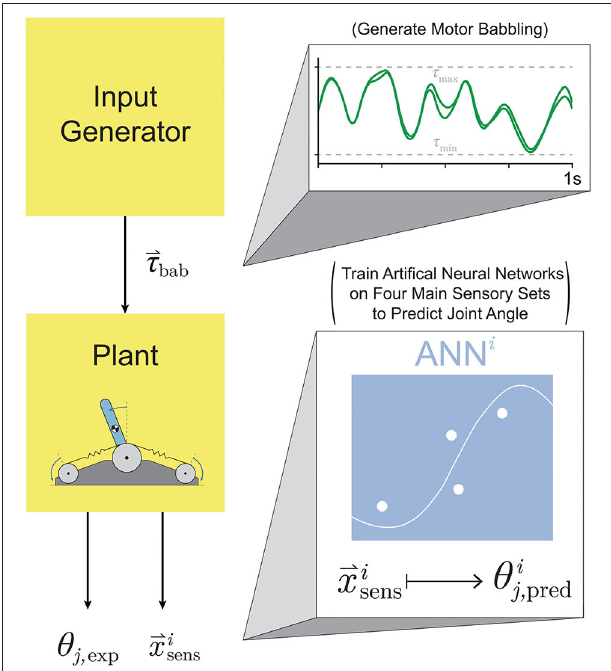
FIGURE 4 | Proposed setup for training ANNs on motor babbling. Random input torques were generated from low frequency, band-limited white noise (1-10 Hz) chosen such that the difference between the two signals forms a normal distribution (0 ± 0.5 Nm). These motor babbling signals ( τ bab ) are passed through the plant, the subsequent sensory information is recorded, and ANNs are trained with the four main sensory sets ( E x i sens ) to predict joint angle ( θ i j ,pred